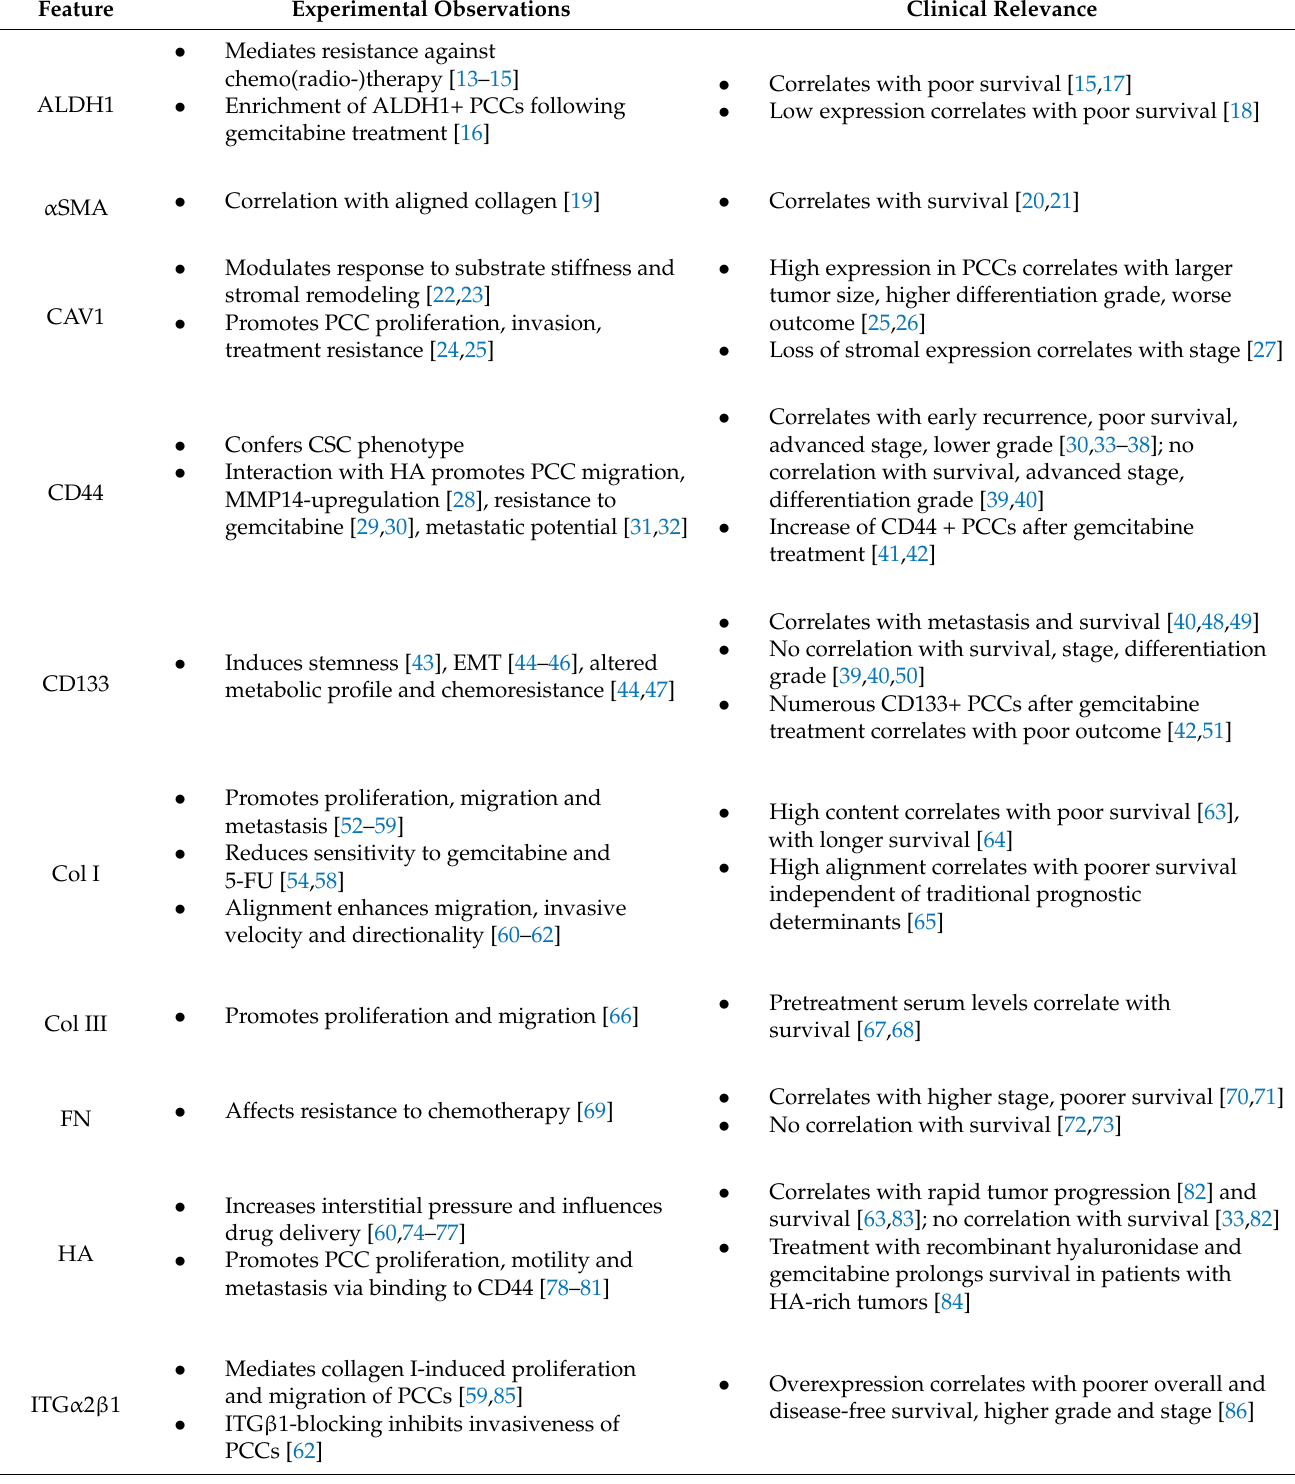
Table 1. Experimental observations and clinical relevance of the listed features in pancreatic cancer.